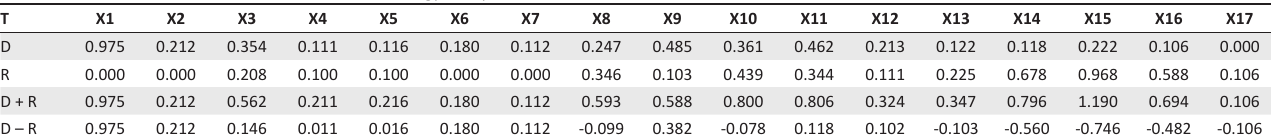
TABLE 3: Causal influence level summarised of Technology Acceptance Model 3.